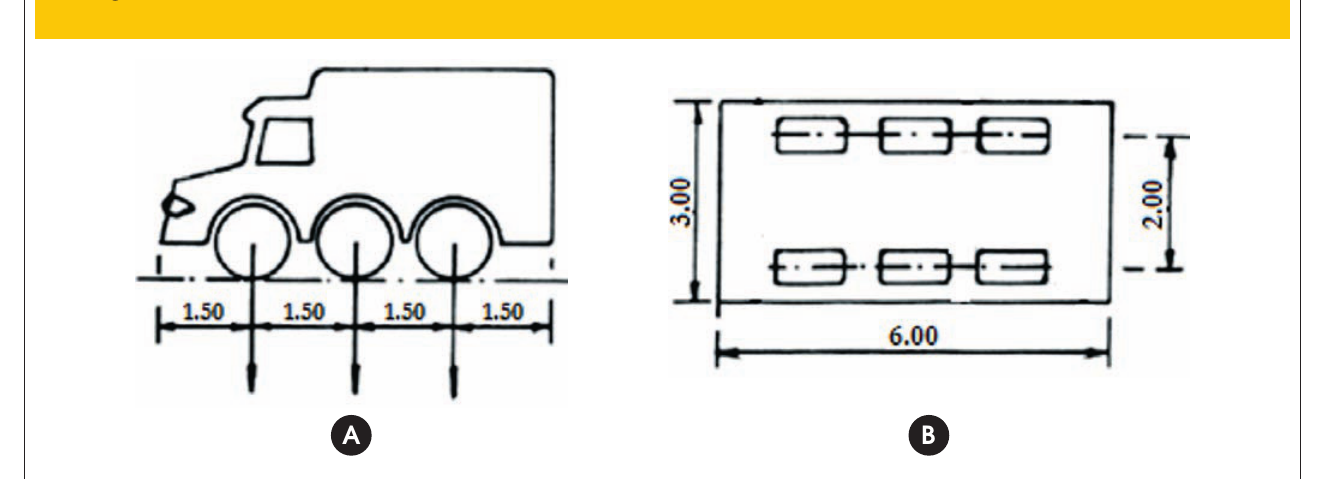
Figure 1 – Current Brazilian load model vehicle (NBR 7188): (a) side view; (b) plan view. Units: